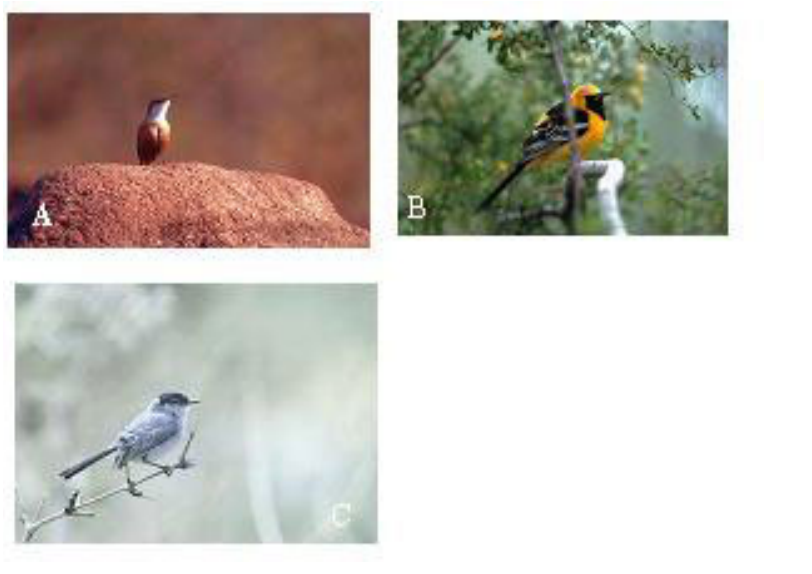
Fig. 5. Some native Arizona bird species found exclusively in upper-income neighborhoods. Photos by Jim Russo (http://birdcentral.net/) A) Cactus wren ( Catherpes mexicanus ); B) Hooded Oriole ( Icterus cucullatus ); and C) Black-tailed gnatcatcher ( Polioptila melanura